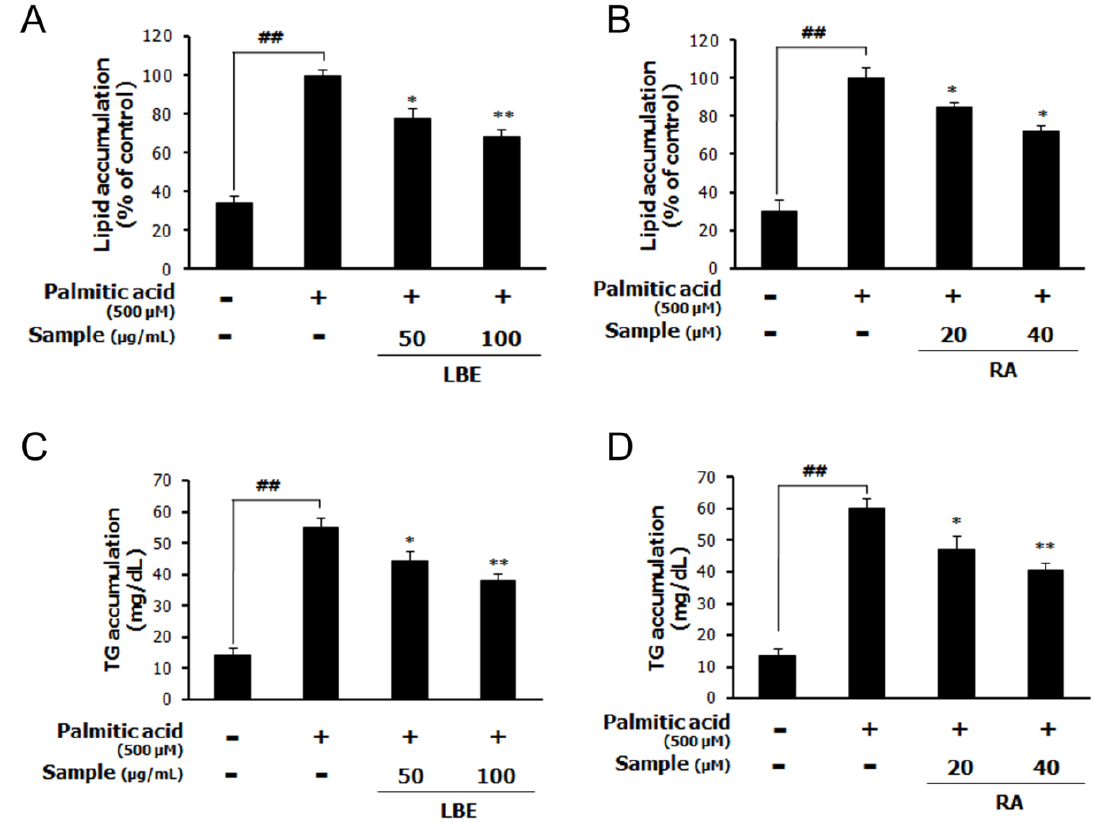
Figure 2. Effects of LBE (lemon balm extract obtained with 20% EtOH) and RA on lipid and TG accumulation in palmitic acid (PA)-treated HepG2 cells. Lipid accumulation with ( A ) LBE and ( B ) RA, and the TG content with ( C ) LBE and ( D ) RA in PA-treated HepG2 cells. Results are expressed as the mean ± SD of three independent experiments. ## p < 0.01 compared with the control group; * p < 0.05 and ** p < 0.01 compared with the PA-treated cells.